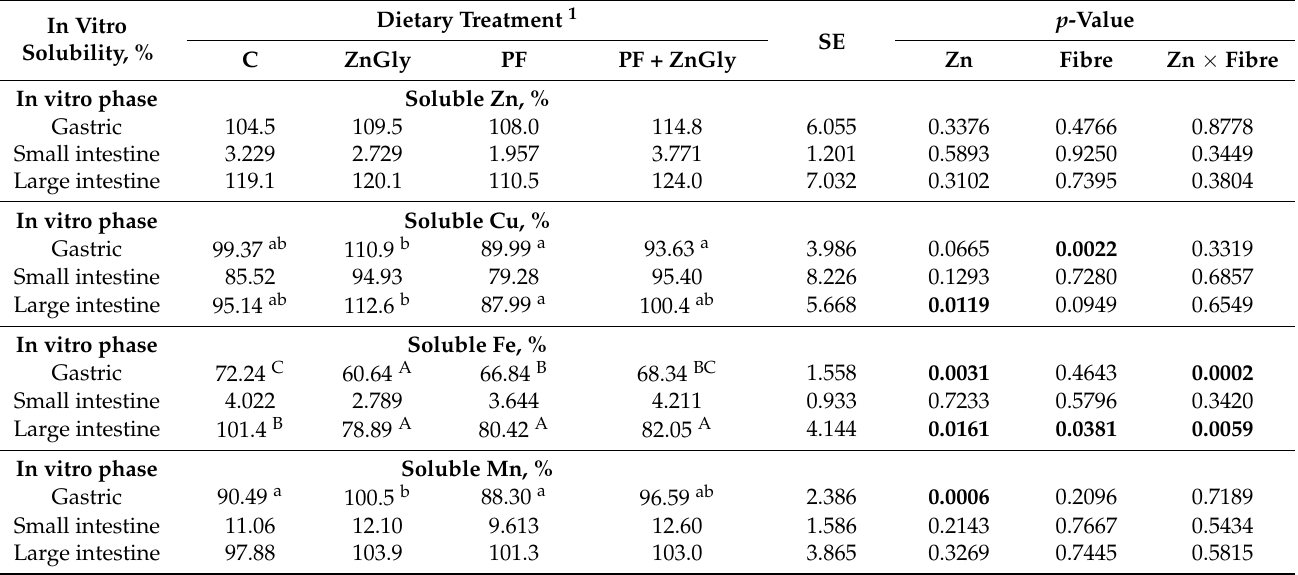
Table 4. In vitro solubility of Zn, Cu, Fe, and Mn from the dietary treatments subjected to three-step in vitro simulated digestion